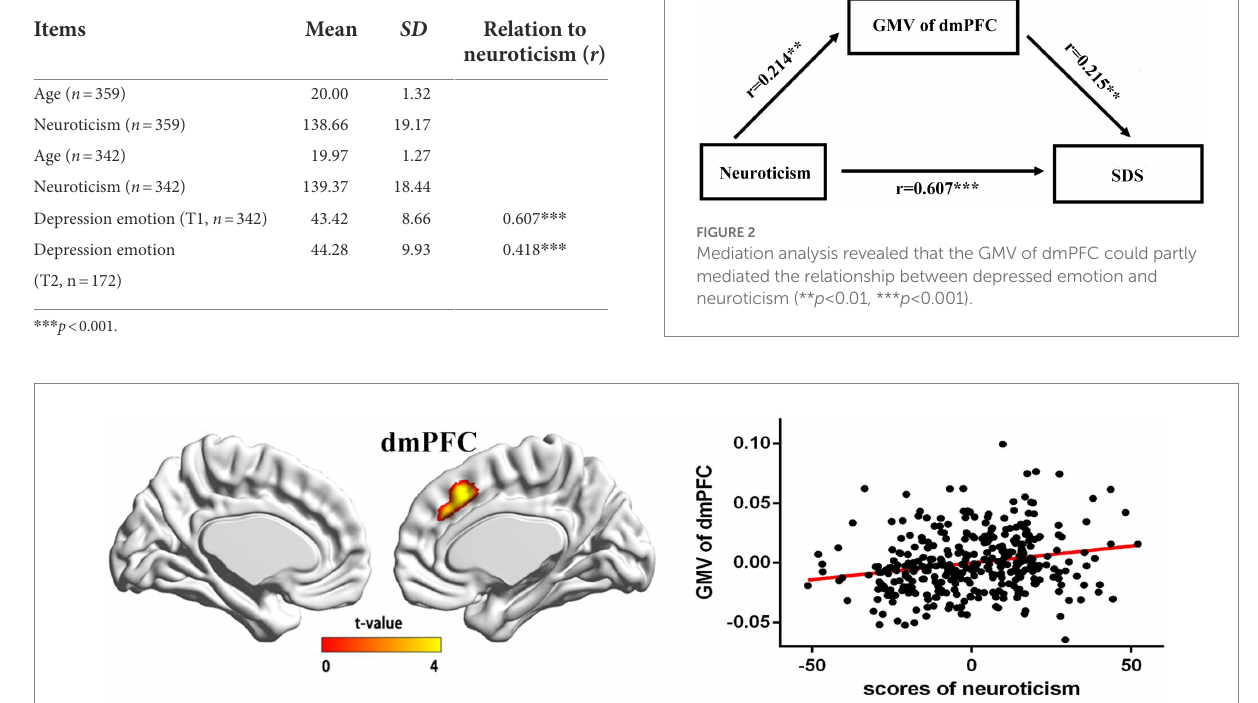
TABLE 1 The characteristics of demographic information about the large young